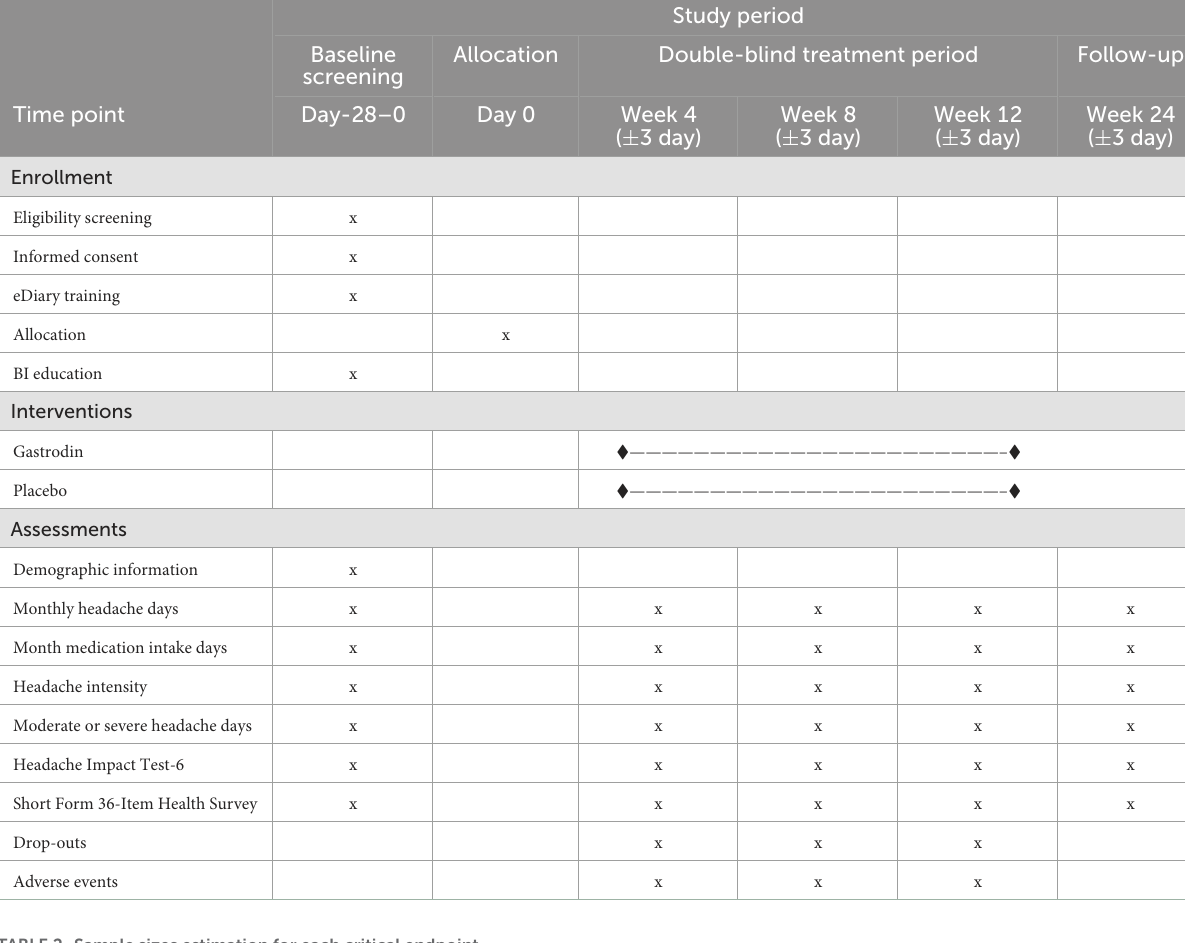
TABLE 2 Sample sizes estimation for each critical